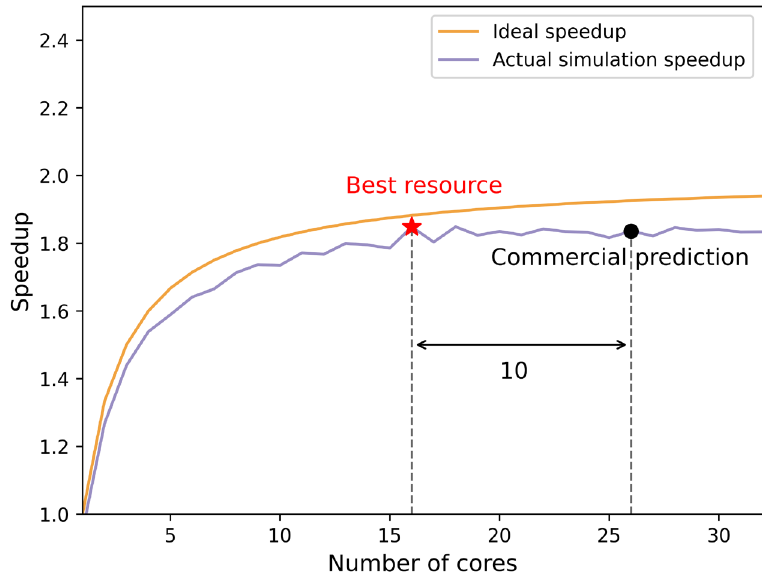
Figure 1. Speedup for simulation that is 50% partially parallelizable. Table 1. Literature